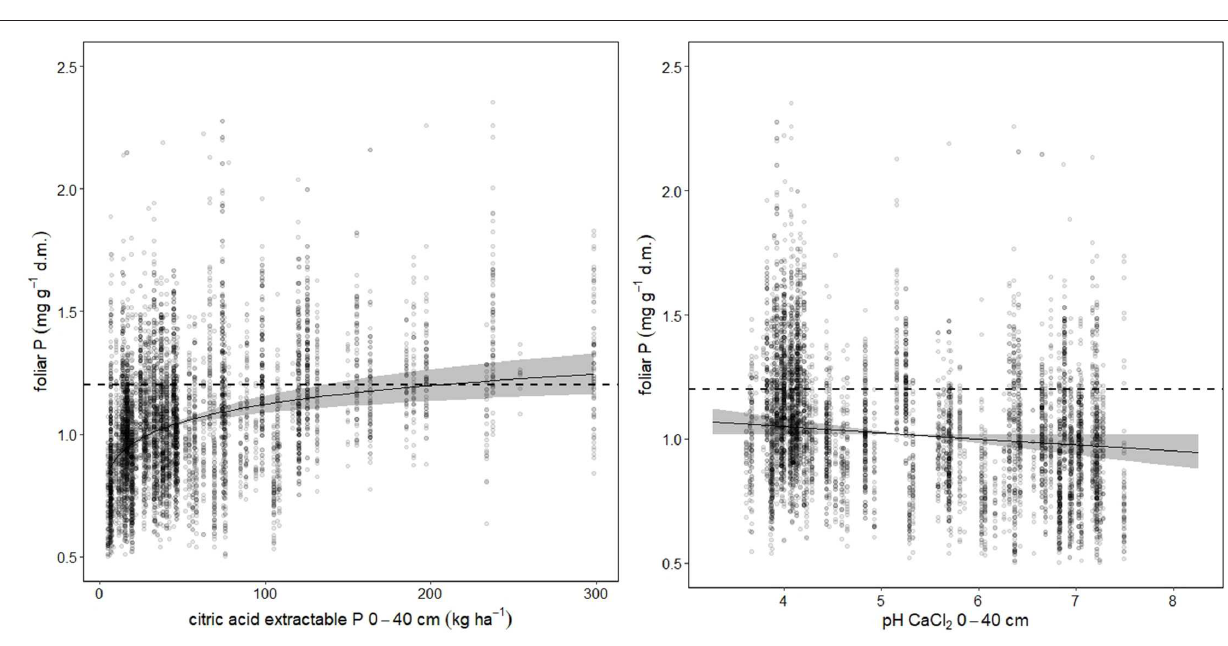
the beginning of the observation period (1984) and negatively in 2015 ( Figure 4 left). Foliar P was negatively related to N deposition in beech. This relation was inexistent in the